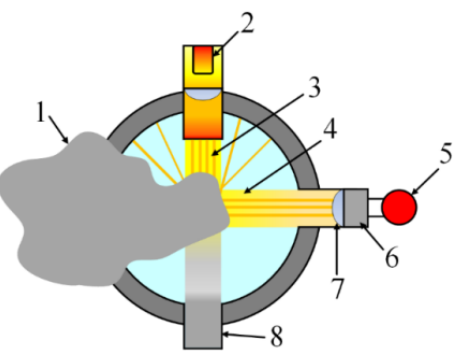
Figure 2. Scheme of the photovoltaic smoke detector [31]: 1—smoke particles; 2—light source; 3—light beam; 4—reflected light; 5—alarm; 6—photocell; 7—lens; 8—light catcher.